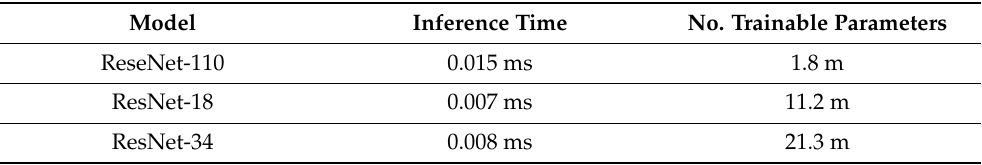
Table 1. The inference time (in milliseconds) and the number of trainable parameters (in millions (m)) for each of the evaluated